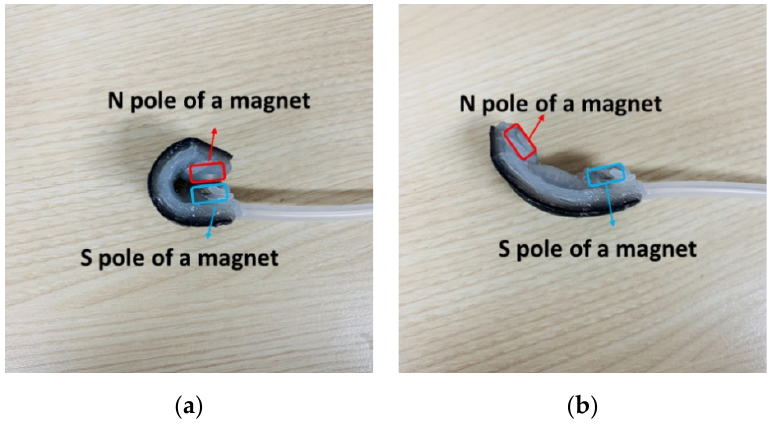
Figure 9. Energy storage using permanent magnets. ( a ) No air is injected in the air chamber; ( b ) air is injected in the air chamber.